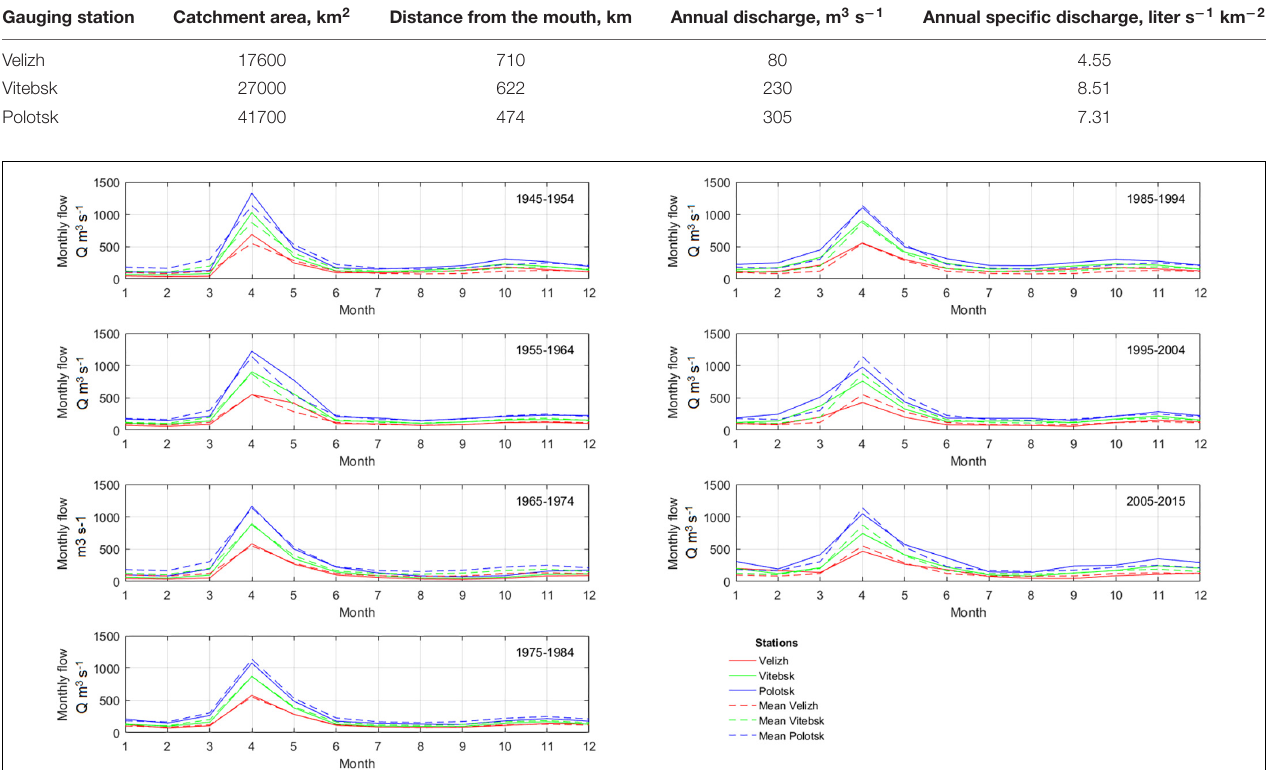
TABLE 2 | Hydrological characteristics of the Western Dvina River (within Russia and Belarus boundaries).